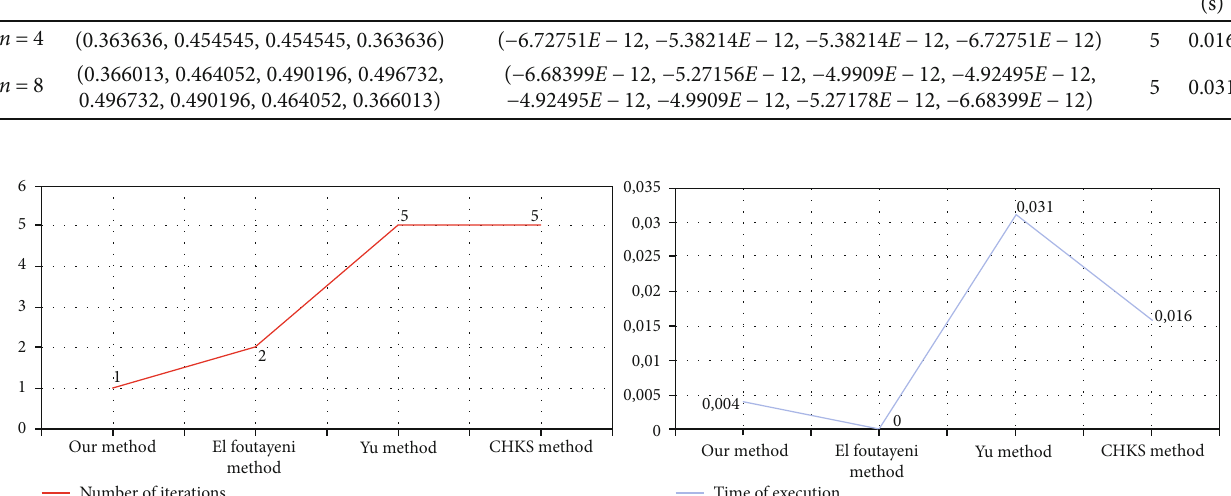
Figure 1: Comparison between our method with the method of El foutayeni, the method of Yu, and the method of CHKS as a function of time and number of iterations in the case where n = 4